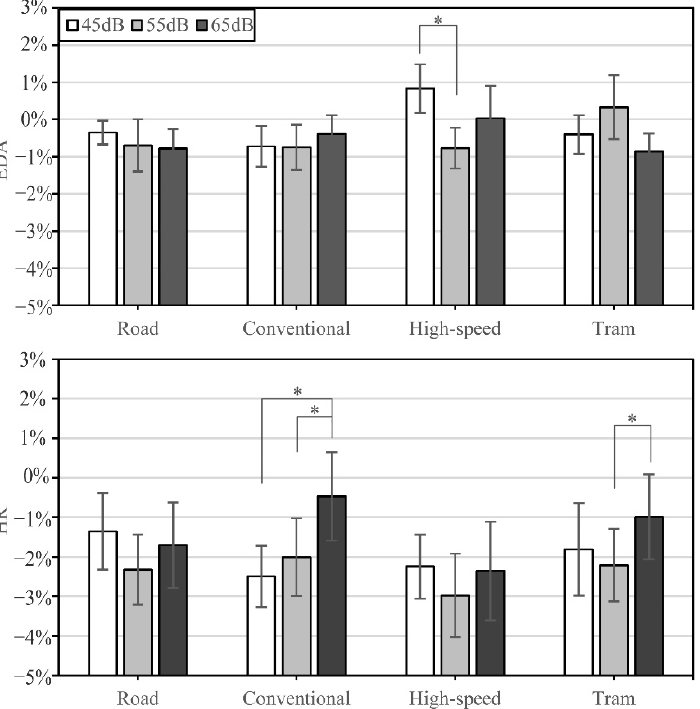
Figure 9. Interaction effect of sound level and sound type on EDA and HR. The vertical bars repre- sent 95% confidence intervals. * represents significant differences in the Mann–Whitney U test at the 0.05 level.